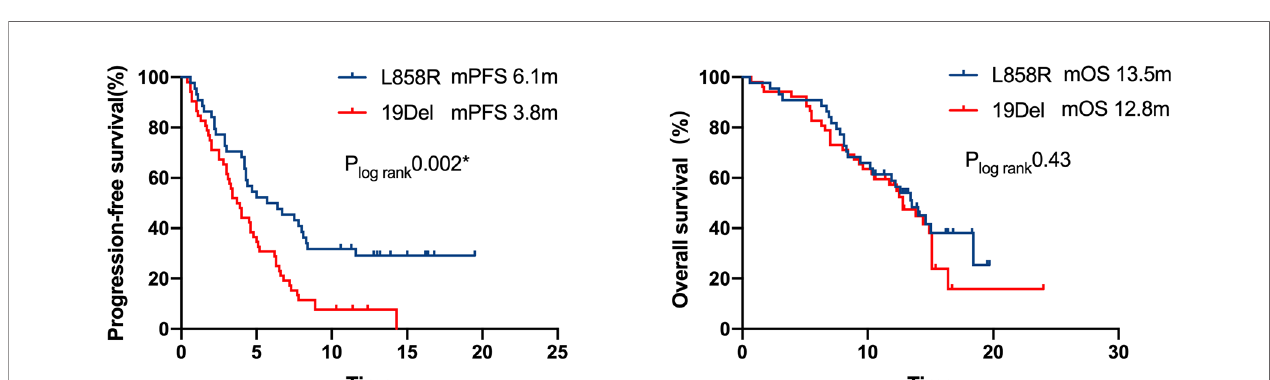
FIGURE 5 | Kaplan – Meier curves of progression-free survival and overall survival of patients with differential mutation type. A signi fi cant PFS bene fi t was observed in patients with L858R compared with that in patients with 19Del (6.1 months vs. 3.8 months, respectively, P = 0.002), but the difference in OS was not statistically signi fi